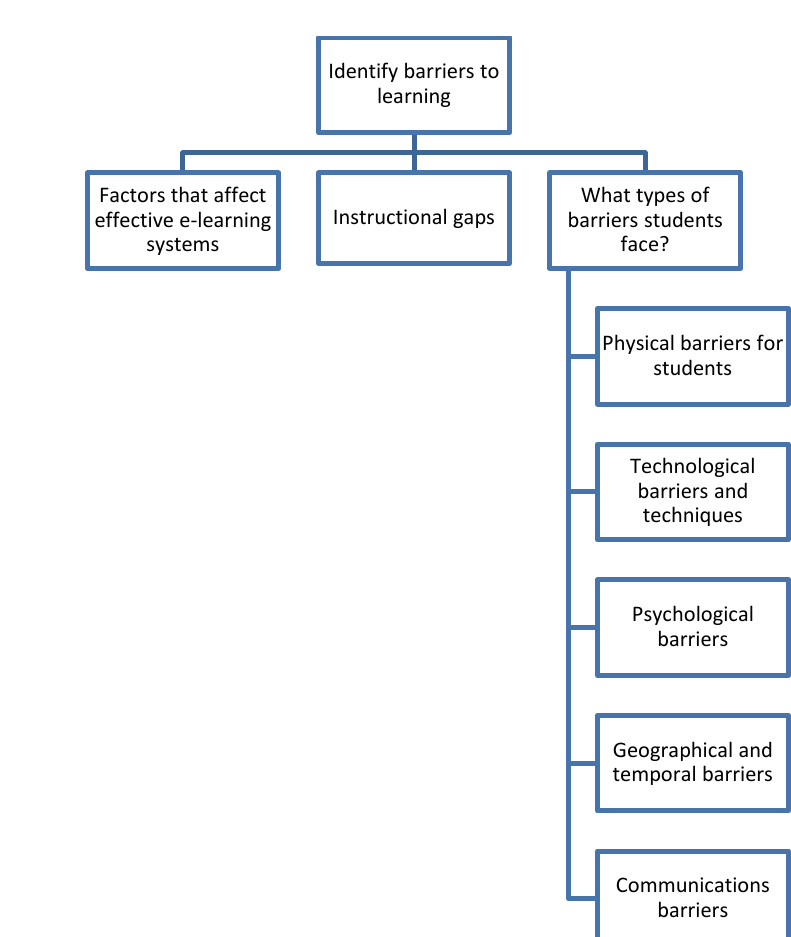
Figure 7 . Identifying barriers to learning. This mind map illustrates the property and its